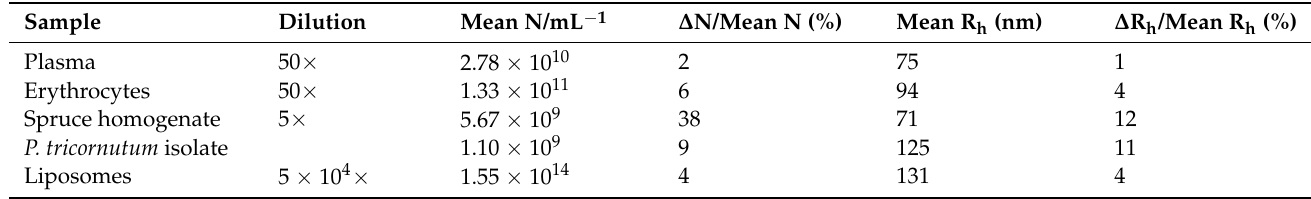
Table 4. Experimental error in selected samples from B, S, P, and L